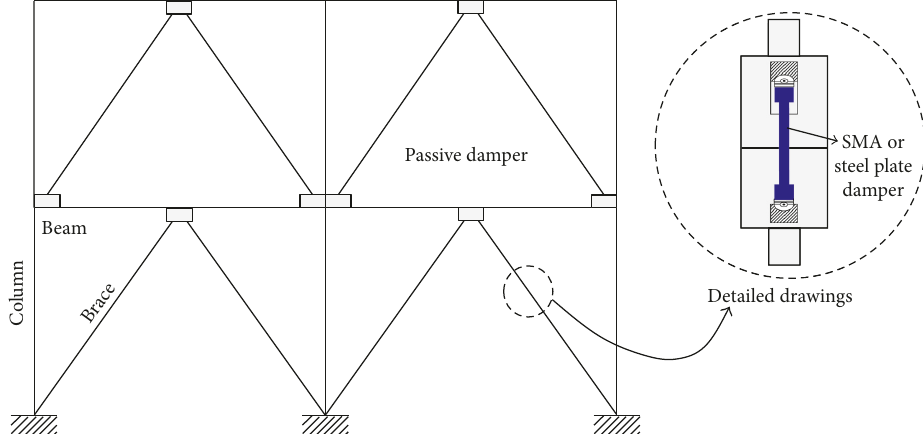
Figure 1: Schematic drawing for the bracing damper systems.